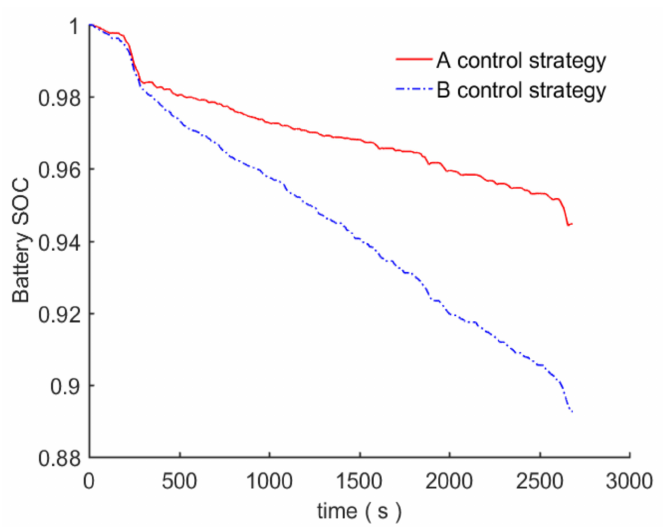
Figure 7. Diagram of M conditions.